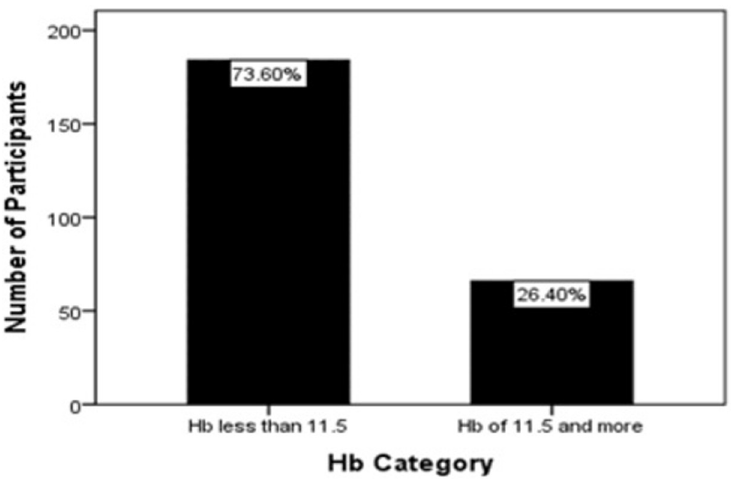
Fig 1. Incidence of anemia among the pregnant women.